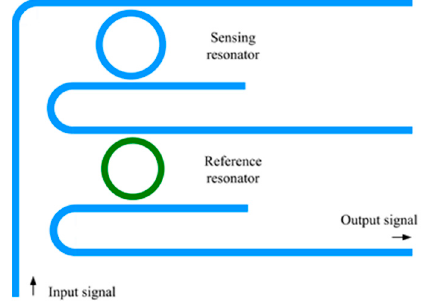
Figure 2. Illustration of the cascaded microring resonators.